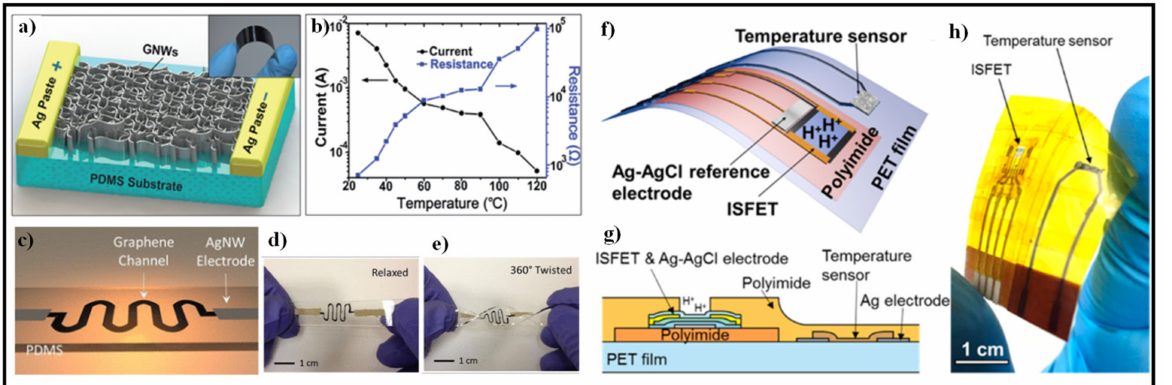
Figure 4. Flexile T sensing apparatuses: ( a ) Schematic of flexile GNWs/PDMS T sensing device. The inset shows the optical image of manufactured flexile sensing device prototype [83]. ( b ) Current and resistance versus temperature curves that span from 25 ◦ C to 120 ◦ C by applying a constant voltage of 5 V at the two terminals of the sensing device [83]. ( c ) Schematic diagram of the stretchable graphene thermistor [84], ( d ) manufactured sensing device in a relaxed state [84], and ( e ) manufactured sensing device in 360 ◦ twisted state. ( f ) Schematic of a wearable apparatus integrating flexible pH and temperature sensors [85], ( g ) cross-sectional diagram of the apparatus [85], and ( h ) photograph of the manufactured device